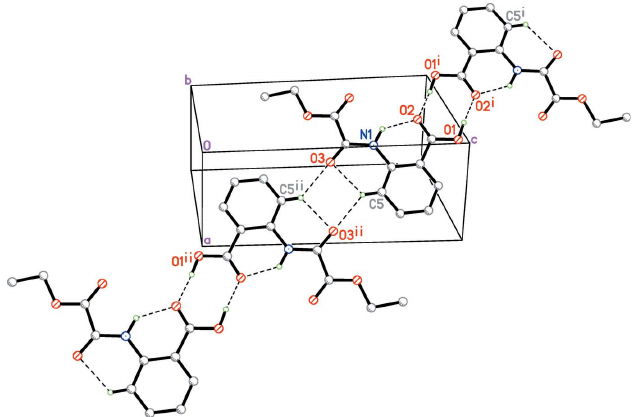
Figure 2 A one-dimensional hydrogen-bonded chain along [111]. Hydrogen bonds (Table 1) are indicated by dashed lines. H atoms not involved in hydrogen bonding are omitted for clarity. Symmetry codes: (i) (cid:4) x , 1 (cid:4) y , 2 (cid:4) z ; (ii) 1 (cid:4) x , (cid:4) y , 1 (cid:4) z .